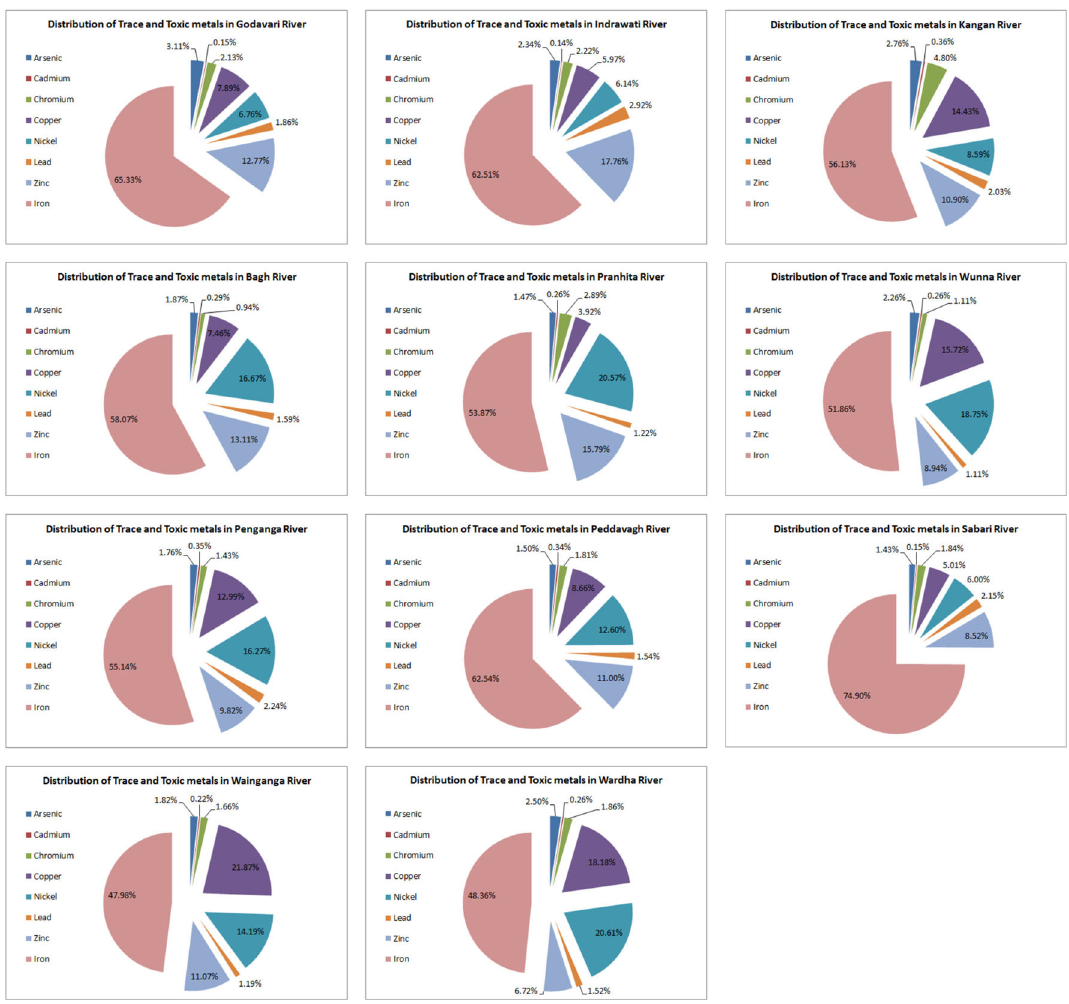
Fig. 4 Distribution of metals in Godavari and its tributaries (Sept. 2011 to Aug.